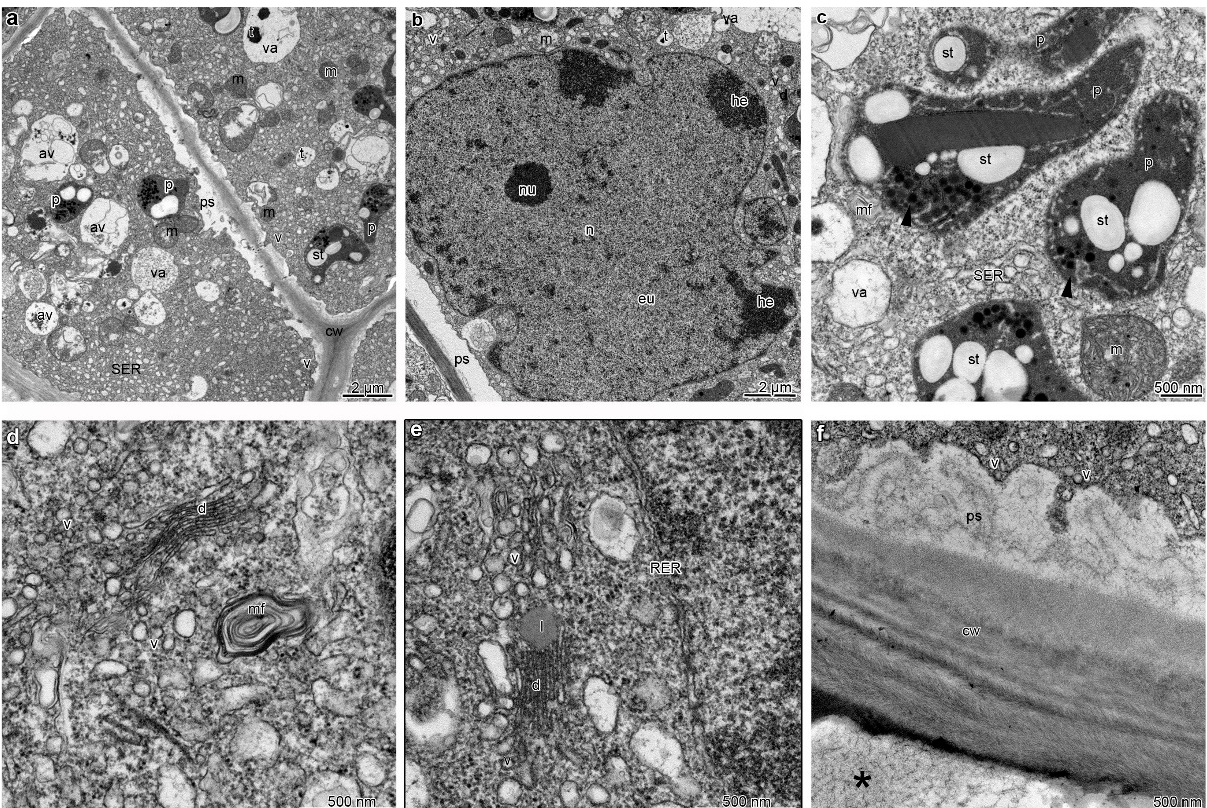
Figure 4. Ultrastructural details (TEM) of the middle lobe of the labellum of B. carunculatum, showing secretory epidermal cells with dense cytoplasm ( a – e ), enlarged nuclei ( b ), numerous small vacuoles, occasionally with osmiophilic (tannin-like) material ( a , c ), an abundance of mitochondria ( a – c ), plastids with starch grains and plastoglobuli ( a , d ), fully developed dictyosomes ( d , e ), profiles of smooth (SER) ( c ) and rough endoplasmic reticulum (RER, ( e )), lipid droplets ( e ), and periplasmic space with flocculated secretory material, numerous vesicles building into plasmalemma, ( f ) and residues of secretion on the epidermis surface (black asterisk). av: Autophagic vacuole, cw: cell wall,